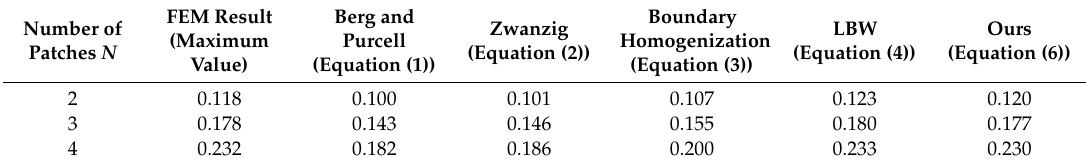
Table 1. Maximum values of the normalized rate constant k from the finite element method (FEM) results (Figure 4), and the calculated values from various theories for N patches on a sphere. To avoid confusion about the maximum values in the FEM results, we round up the values to three decimal points so that the maximum values are the values at φ = 180 ◦ ( N = 2), 120 ◦ ( N = 3), and 109.5 ◦ ( N = 4), which correspond to symmetric arrangements of the patches. Number of Patches 𝑁